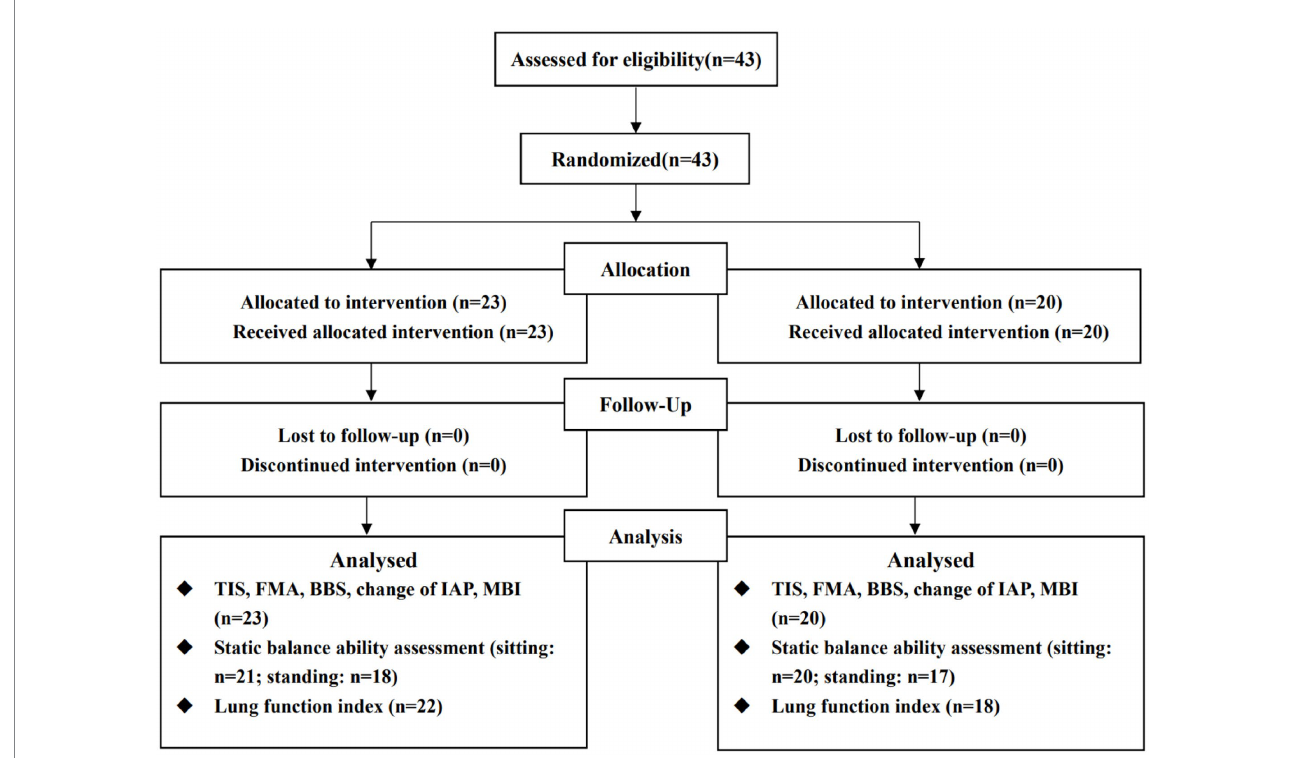
FIGURE 3 Flow chart. The reason for the missing number of measurement indexes is that some subject could not complete the corresponding evaluation content, according to the unified evaluation standards, due to their functional